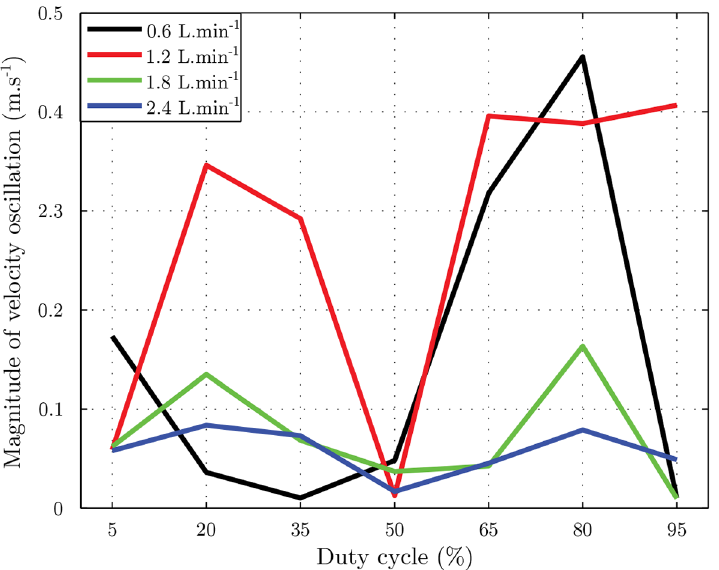
Fig 8. Flow velocity oscillations. Measure of air velocity oscillation caused by the use of PWM for airflow of 0.6, 1.2, 1.8 and 2.4 L.min − 1 and with seven values of a duty cycle from 5 to 95% with step of